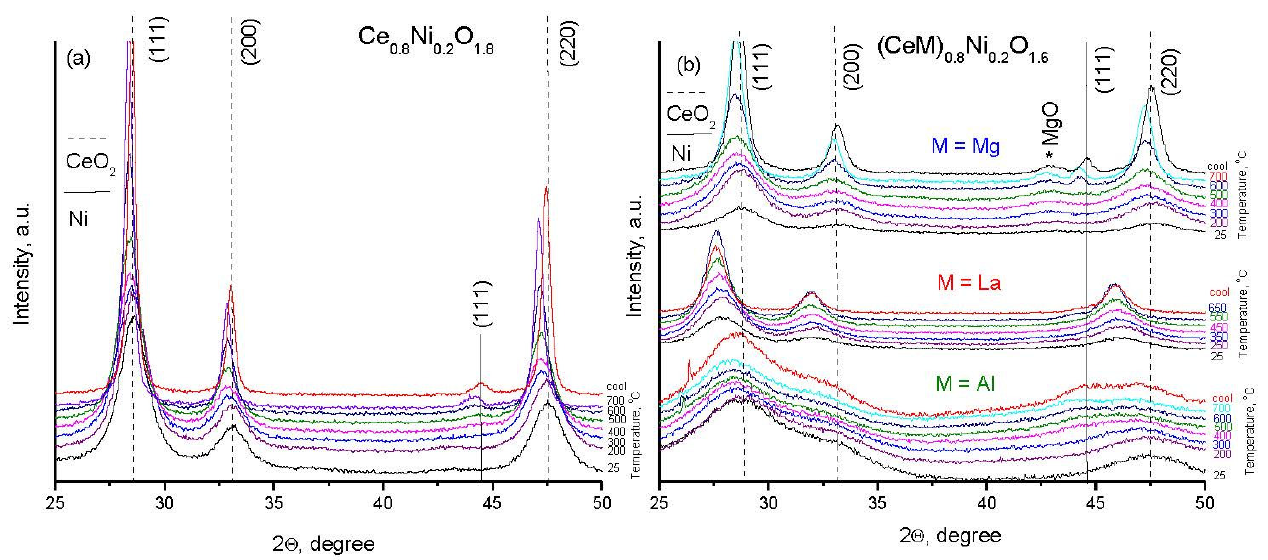
Figure 12. In situ XRD patterns for (CeM) 1 − x Ni x O y samples under reduction in a 30%H 2 /70%He mix- ture as a function of temperature: ( a ) Ce 0.8 Ni 0.2 O 1.8 , ( b ) Ce 0.4 M 0.4 Ni 0.2 O y . Arrows indicate the shift in the reflection (220) of the CeO 2 phase due to doping with lanthanum cations.